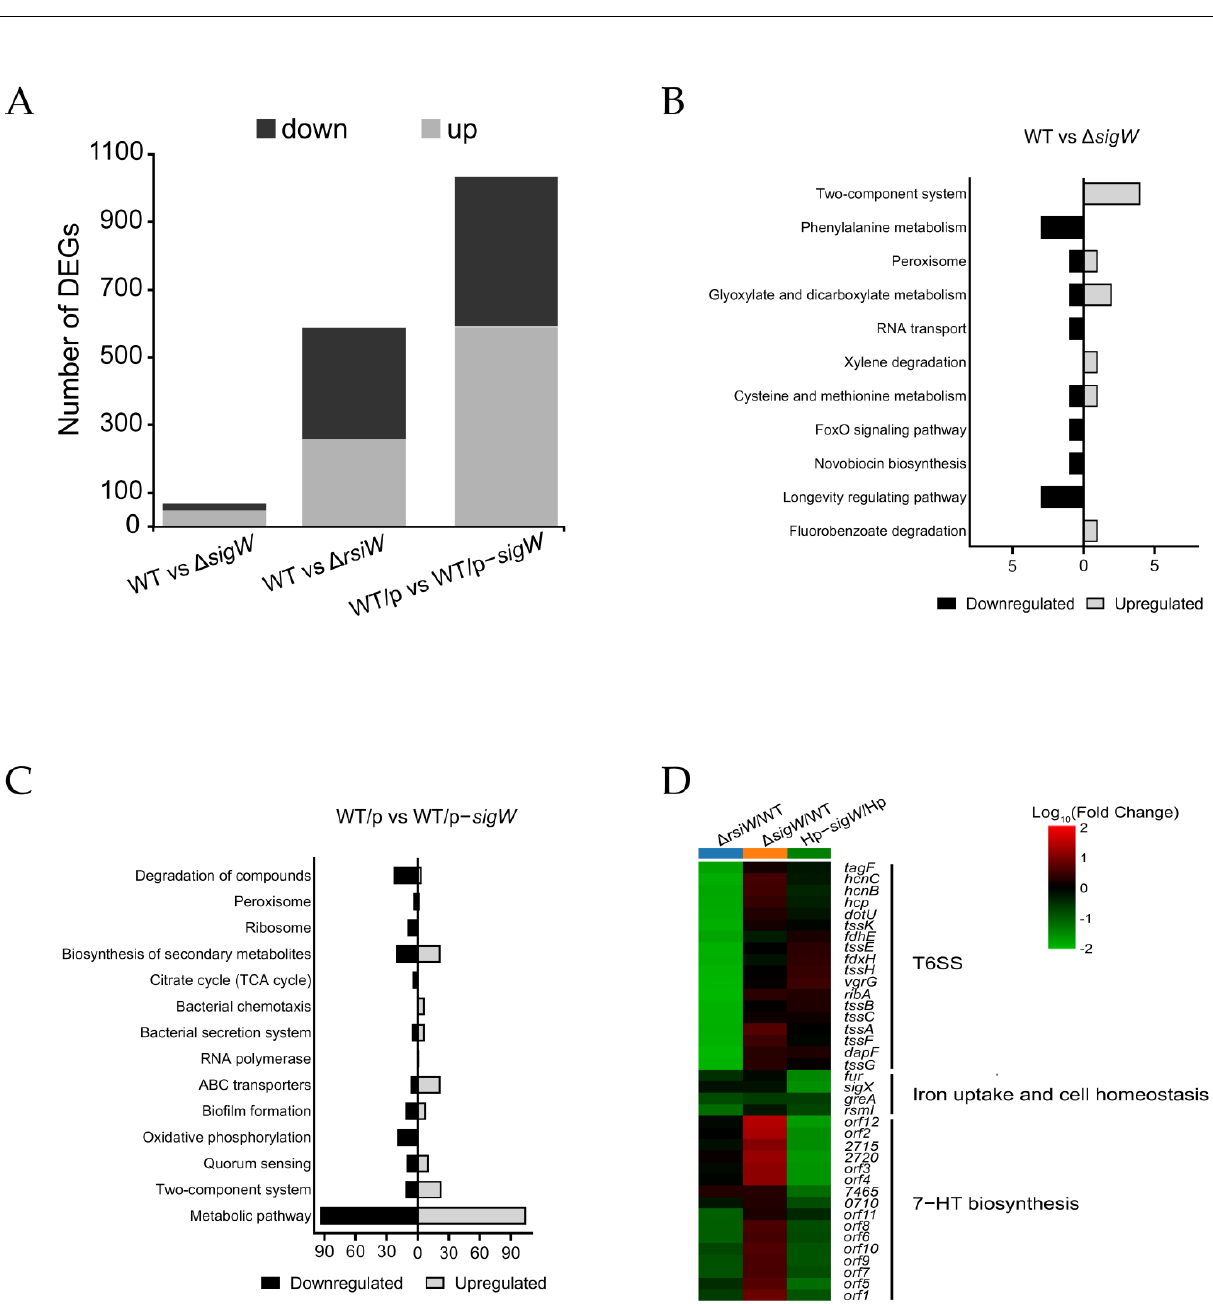
Figure 3. Transcriptional profiling with RNA sequencing identified SigW/RsiW regulated genes in P. donghuensis HYS. Wild-type strains lacking sigW or rsiW or carrying pBBR2- sigW (overexpressing sigW ), grown in MKB medium were analyzed by RNA sequencing. ( A ) Stacking diagram representing the number of differential genes among the three groups. The black and grey bars represent down- and upregulated genes, respectively. In the three comparison groups, the total number of differential genes was 66, 585, and 1032, respectively. The graph was created based on the mean value of fold changes in triplicates. Kyoto Encyclopedia of Genes and Genomes (KEGG) analysis of differentially expressed genes ( B ) ( ∆ sigW vs. HYS) and ( C ) (HYS/pBBR2 − sigW vs. HYS/pBBR2). The black and grey bars represent down- and upregulated genes, respectively, while the bars represent the number of genes related to that pathway. Selection of enrichment pathways with p values less than 0.05 is shown in the histogram. p -values < 0.05 indicate that the function was significantly enriched. ( D ) Heatmap demonstrating a selection of genes differentially expressed in the comparisons are indicated above each column. The diagram was based on the mean value of fold changes in